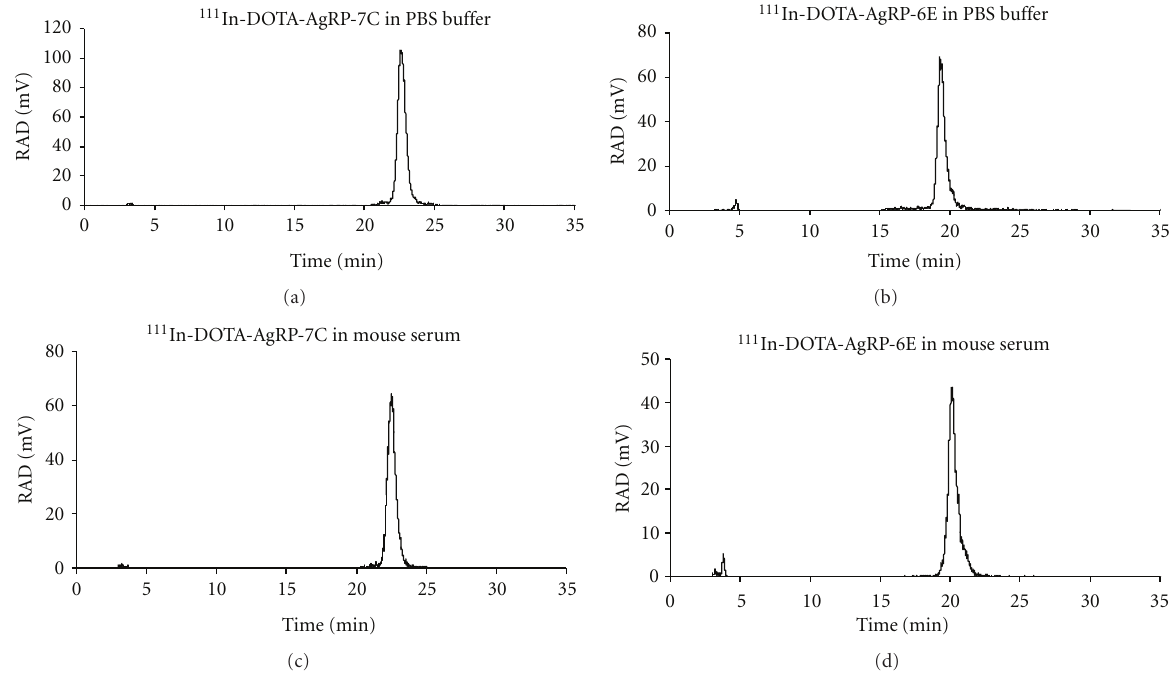
Figure 1: Stability analysis of 111 In-DOTA-AgRP-7C (a) and (b), and 111 In-DOTA-AgRP-6E (c) and (d) in PBS and mouse serum. The two radiopeptides were incubated with PBS for 24 h at room temperature, and mouse serum for 2h at 37 ◦